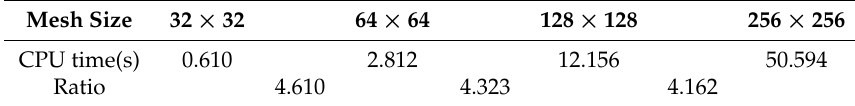
Table 9. CPU times for different mesh